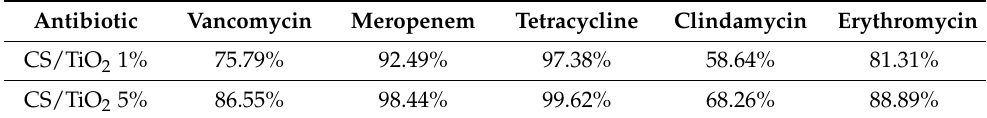
Table 5. Antibiotic removal efficiency (%) of chitosan/TiO 2 composite membranes at 48 h. Antibiotic